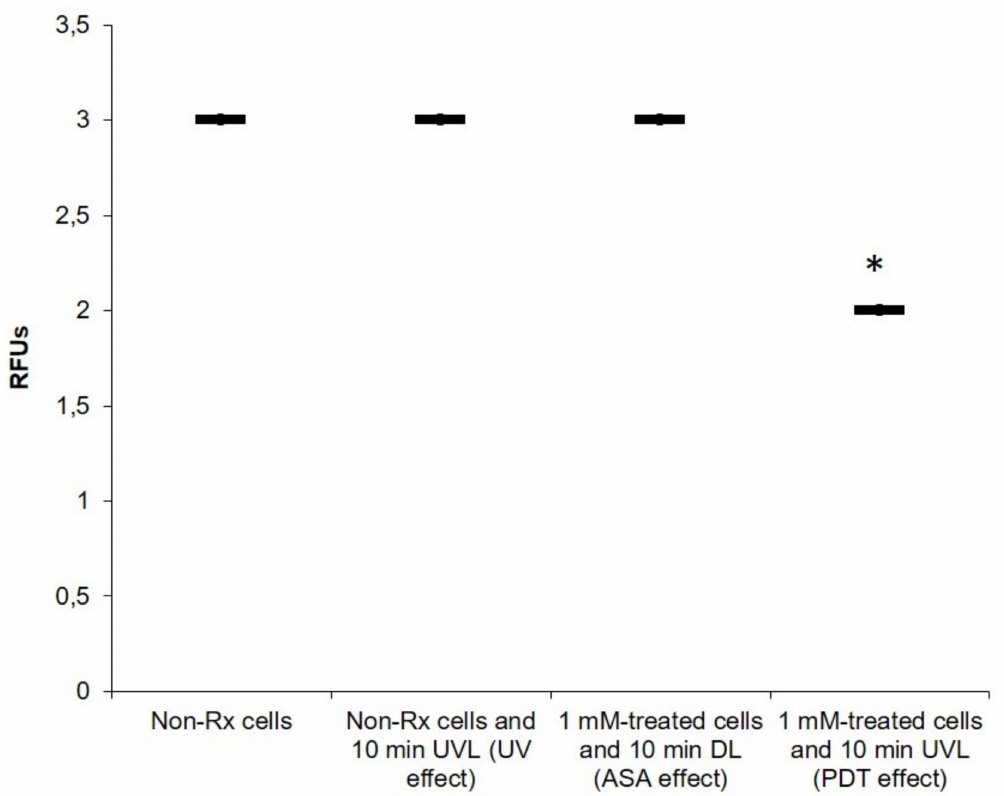
Figure 5. The effect of different experimental conditions on the expression of the CAP64 gene in C. neoformans LMPE 046. Non-Rx, non-treated cells; UVL, ultraviolet light; DL, dark light; RFUs, relative fluorescence units. Data points were obtained from three biological replicates for each defined experimental condition. * Significantly different from non-Rx cells at p <